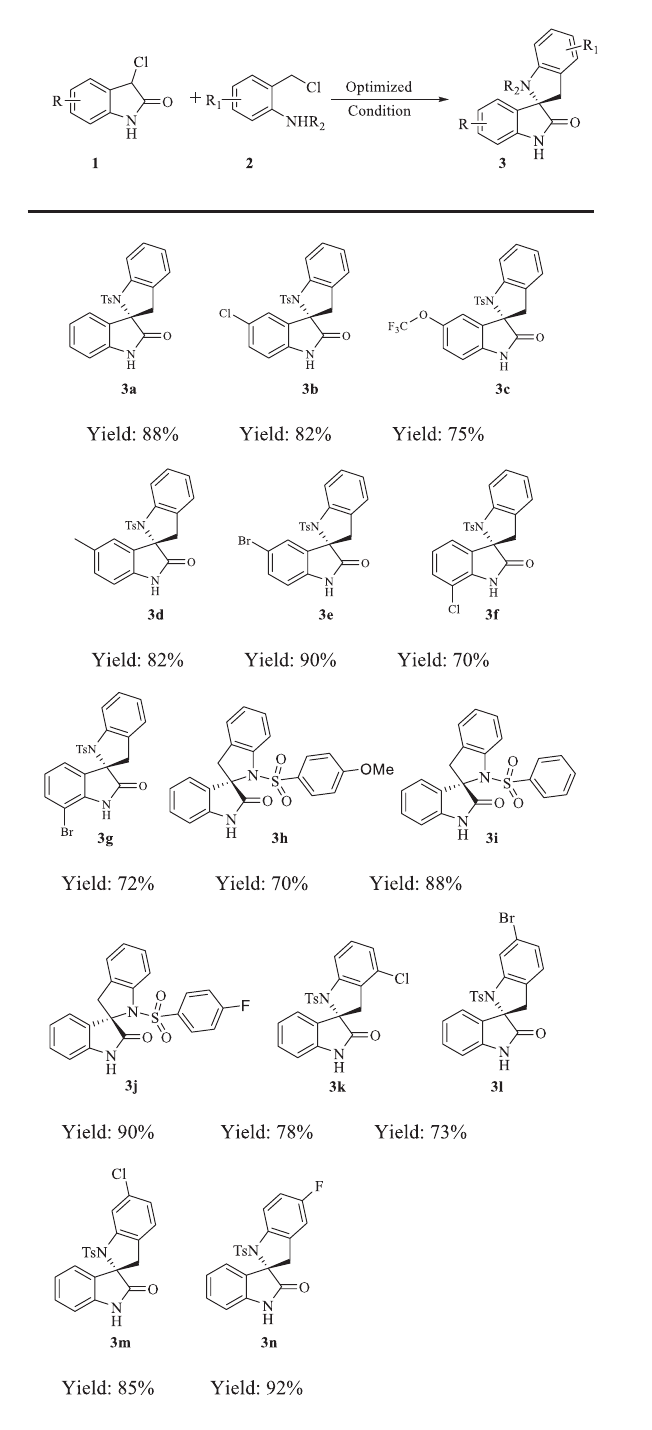
TABLE 2 | Substrate